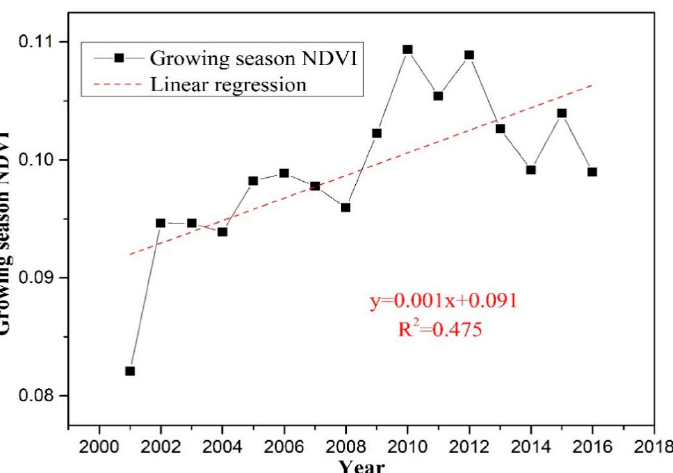
Figure 3. The variation of the Normalized Difference Vegetation Index (NDVI) in the Qaidam Basin.